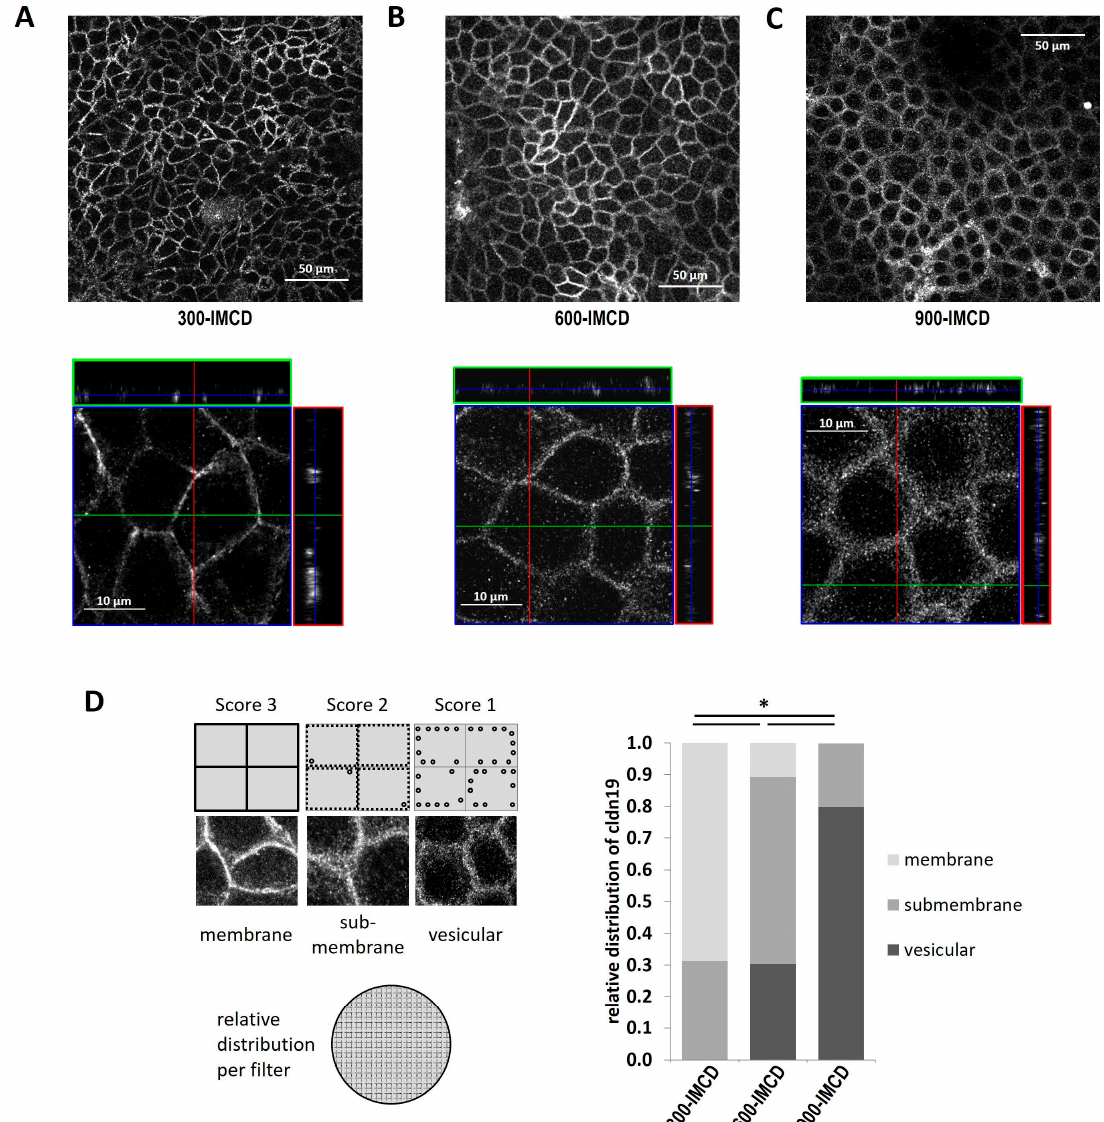
Figure 8. Immunofluorescence of claudin-19 ( A ) in 300-IMCD, ( B ) in 600-IMCD, and ( C ) in 900-IMCD, shown in an xy-overview (upper panel) and a representative z-stack (lower panel). ( D ) Summarized subcellular localization of claudin-19 in the categories of membrane TJ staining, submembrane and intracellular vesicular staining (schematic drawing), n = 12, 14, 12.